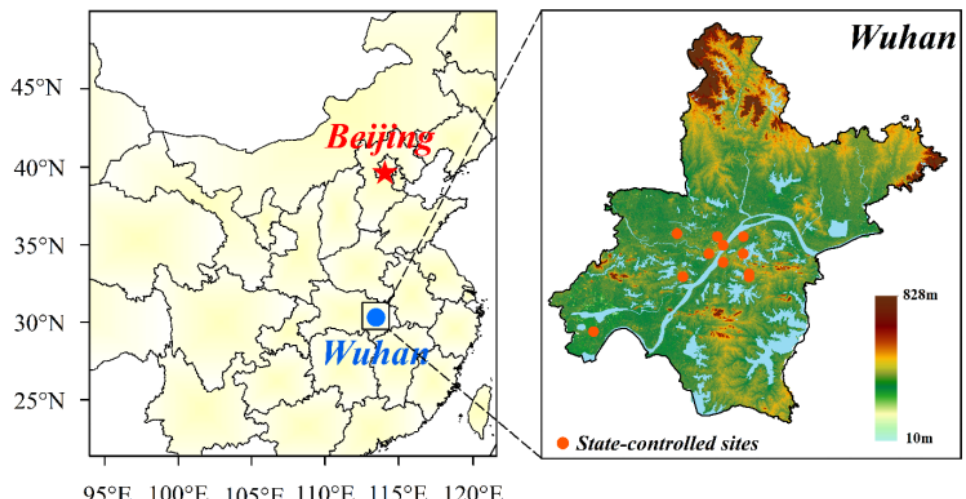
Figure 1. ( Left panel ) Locations of Wuhan in China and ( right panel ) detailed sites of ambient air quality monitoring in Wuhan with the topographic heights (in m.a.s.l.).